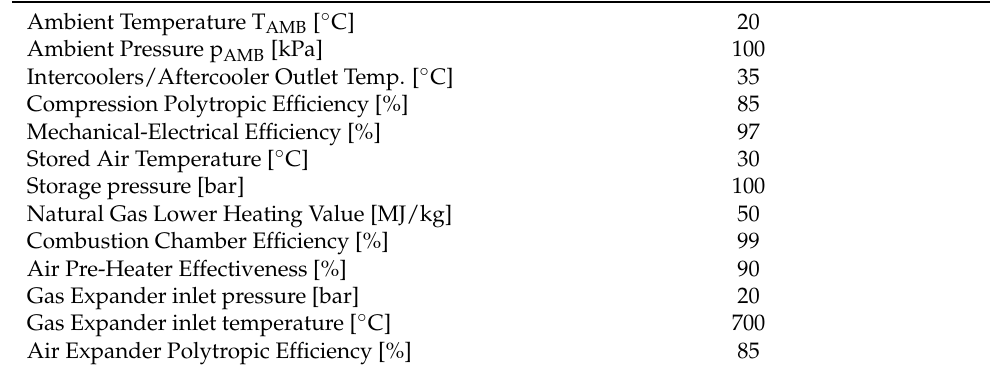
Table 1. Main Assumption for D-CAES thermodynamic